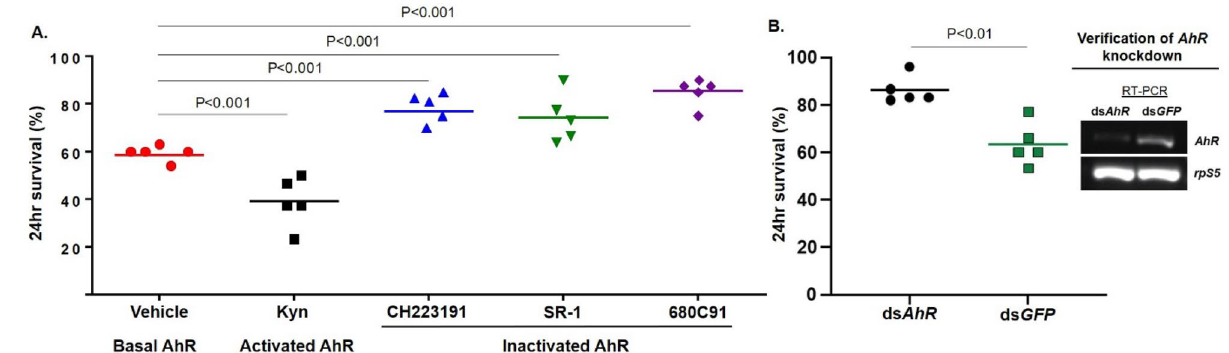
Figure 1. Mosquito survival upon bacterial challenge when AhR activity is manipulated pharmacologically or genetically. ( A ) The effect of pharmacological manipulation of AhR activity on the survival post Serratia challenge. Average 24 h-survival (%) was denoted by the line. ( B ) The effect of AhR silencing on the survival post-challenge. The AhR knockdown was verified by RT-PCR. The 24 h-survival data were generated from 5 replicates and tested by